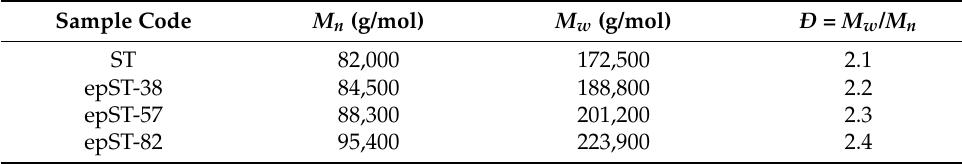
Figure 4. Gel Permeation Chromatography (GPC) plots of virgin ST and epST-x. Table 2. Molecular characteristics from GPC of virgin ST and epST-x.